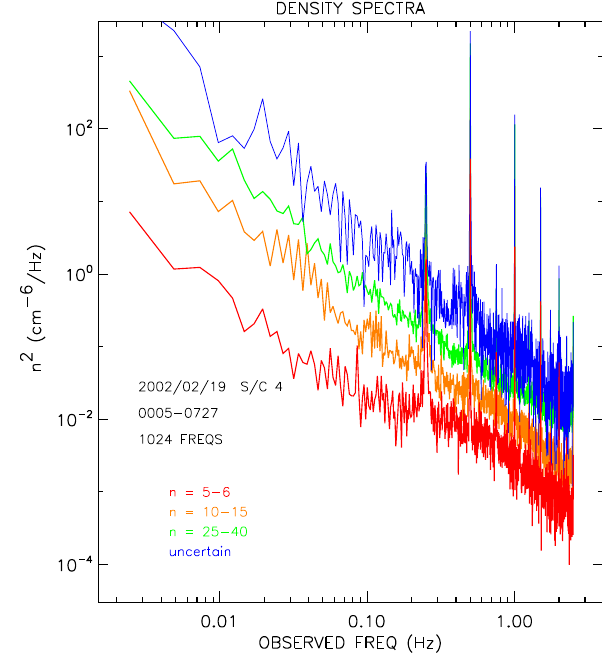
Fig. 4. Density fluctuations spectra in several density